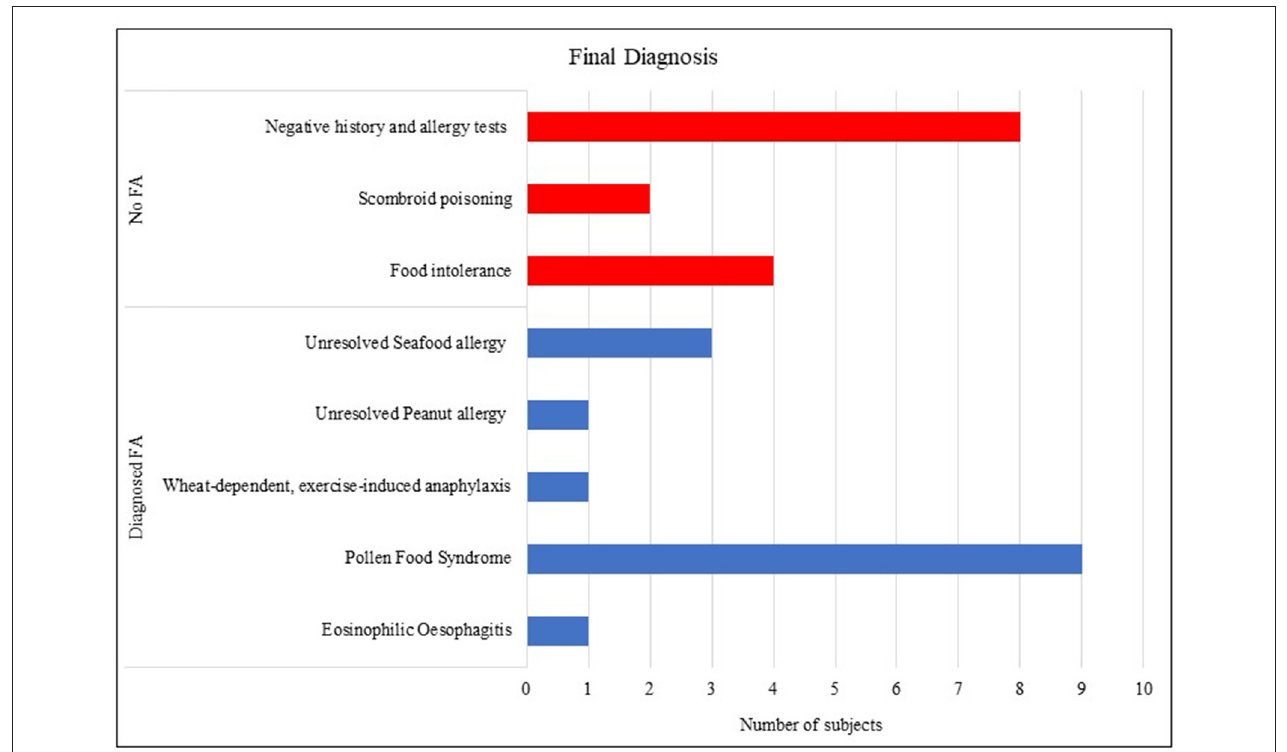
FIGURE 1 | Final diagnosis of the study participants based on history, tests and expert evaluation.